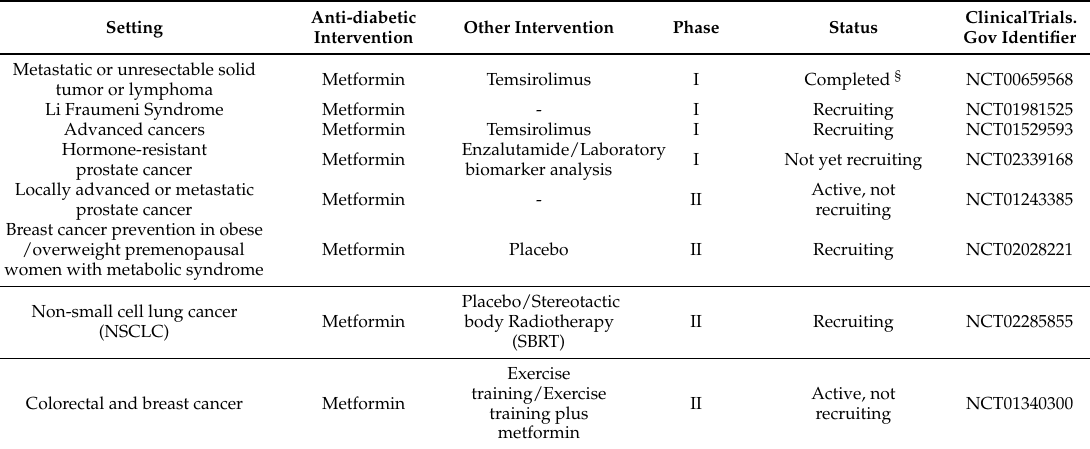
Table 1. Selected Active or Completed Clinical Trials on metformin and pioglitazone for cancer therapeutics or cancer